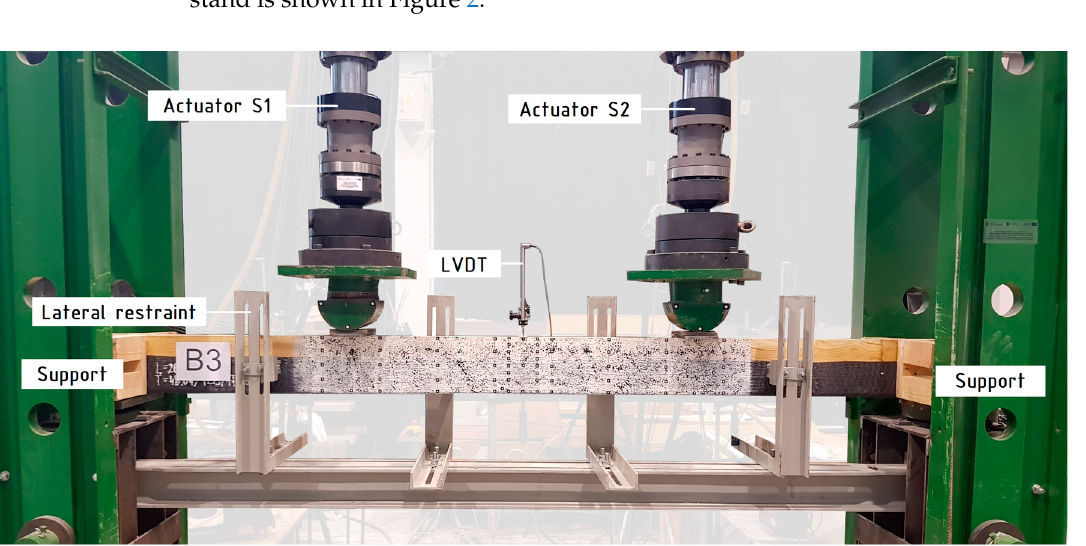
Figure 2. Image of the test setup.